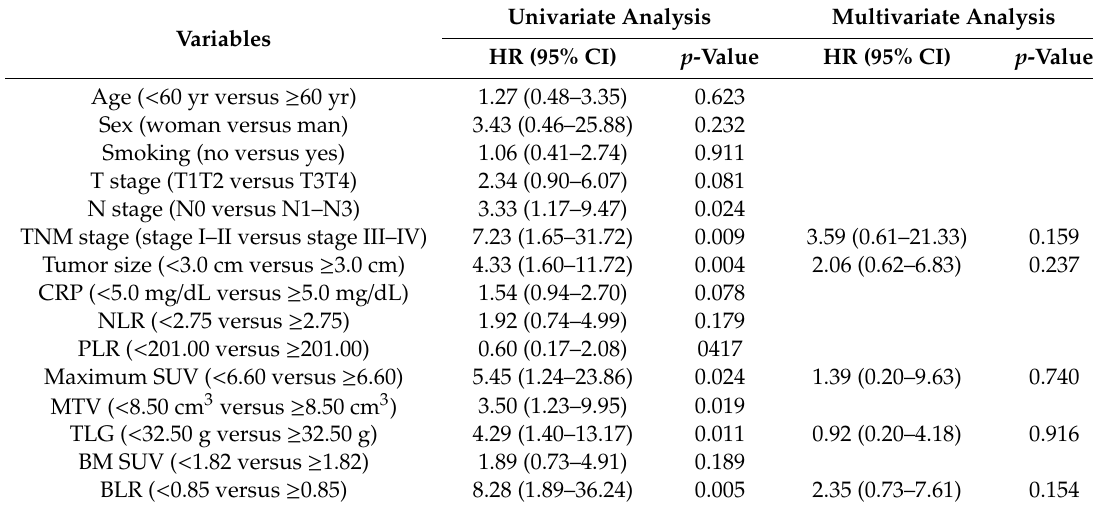
Table 4. Univariate and multivariate analyses of distant failure-free